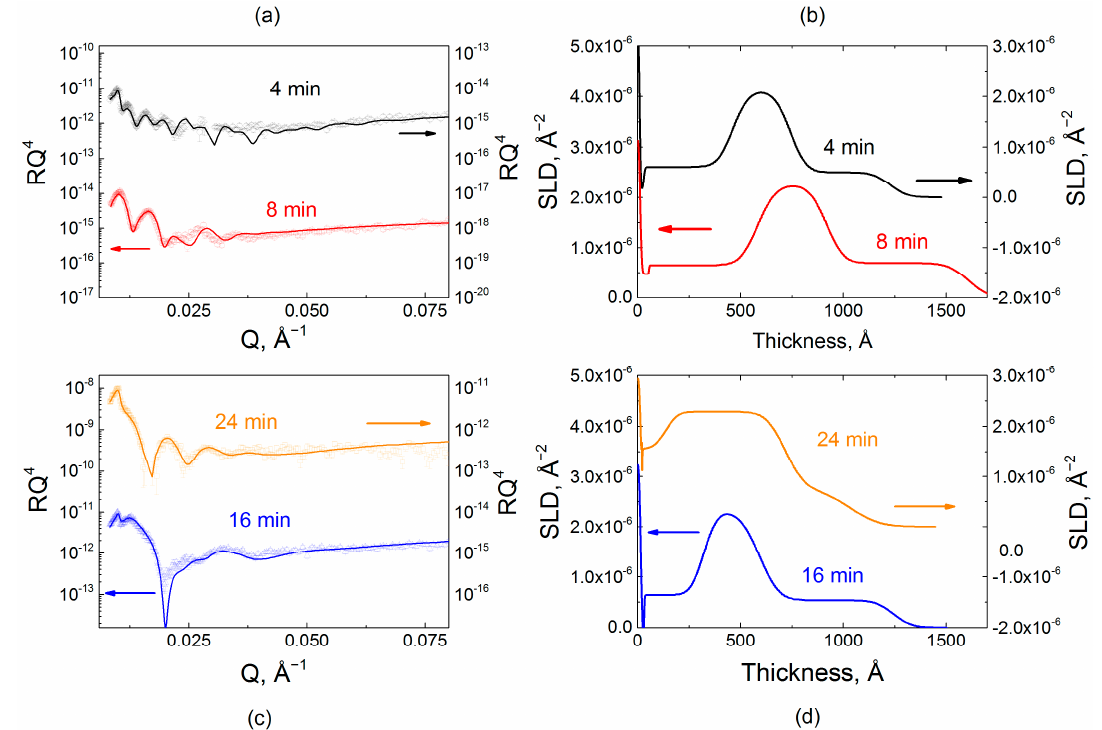
Figure 4. Reflectometry data ( a , c ) and scattering length density profiles for PMAA/QPC films formed using hydrogenated and deuterated components; ( b ) SLD profiles of films assembled using d PMAA as a marker layer with layer sequences QPC 8 / d PMAA 9 /QPC 144min and QPC 8 / d PMAA 9 /QPC 148min , (black and red lines, respectively); ( d ) SLD profiles of films assembled using d PMAA as a marker layer with layer sequences QPC 4 / d PMAA 5 /QPC 1016min and QPC 4 / d PMAA 5 /QPC 824min for samples with 16 and 24 min deposition times (blue and orange lines, respectively).